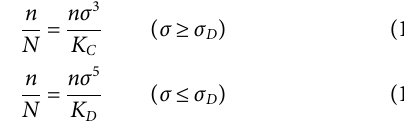
Frontiers in Materials |